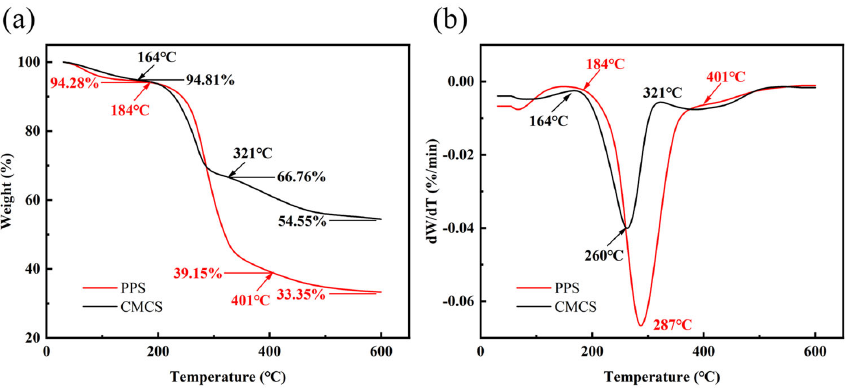
Figure 4. The thermal properties of PPS and CMCS. ( a ) Thermogravimetric (TG) analysis curves of PPS and CMCS; ( b ) Differential thermogravimetric (DTG) curves of PPS and CMCS. The TG curve indicated the residual mass of CMCS (54.55%) after thermal decompo-